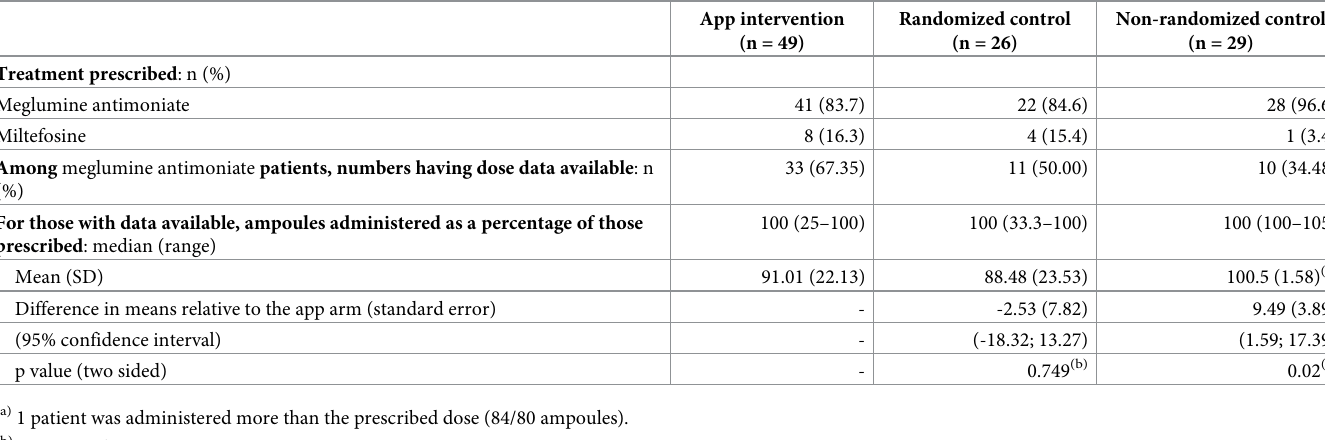
Table 2. Clinical status at end of treatment, and adherence with prescribed